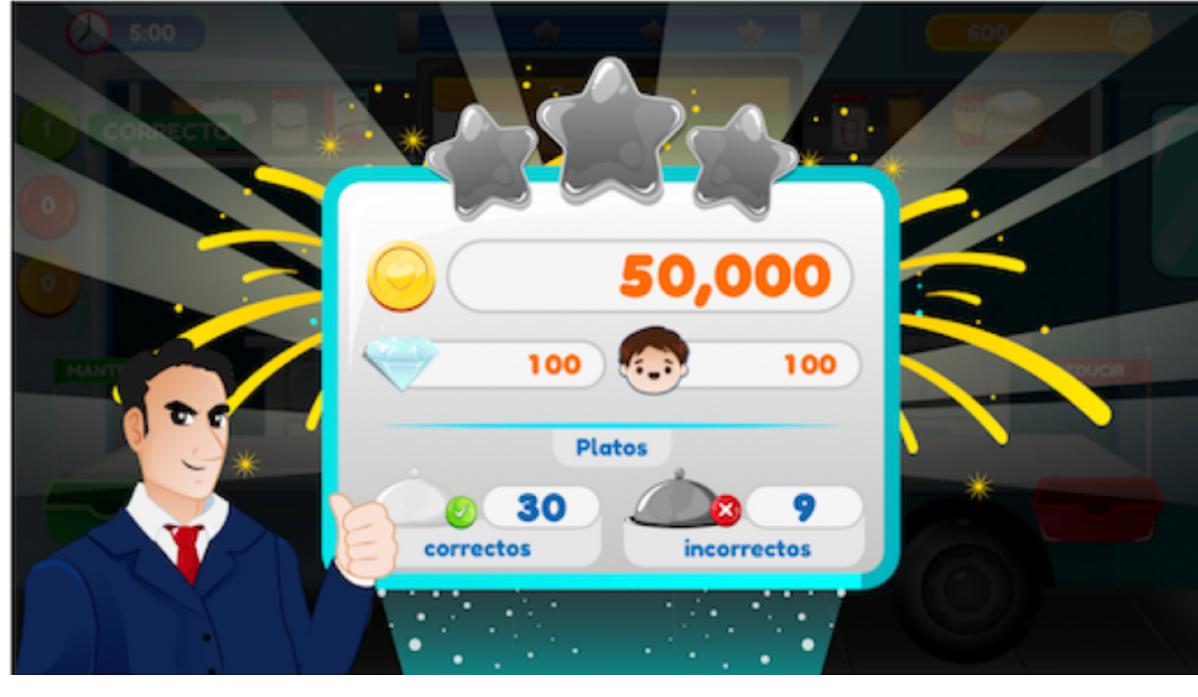
Figure 3. FoodRateMaster level results screen.